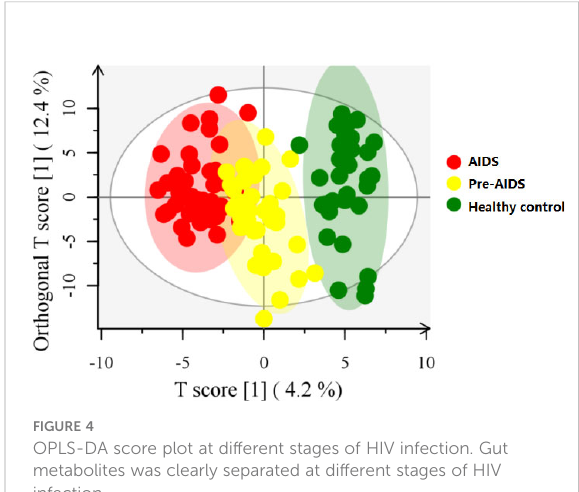
FIGURE 4 OPLS-DA score plot at different stages of HIV infection. Gut metabolites was clearly separated at different stages of HIV infection.